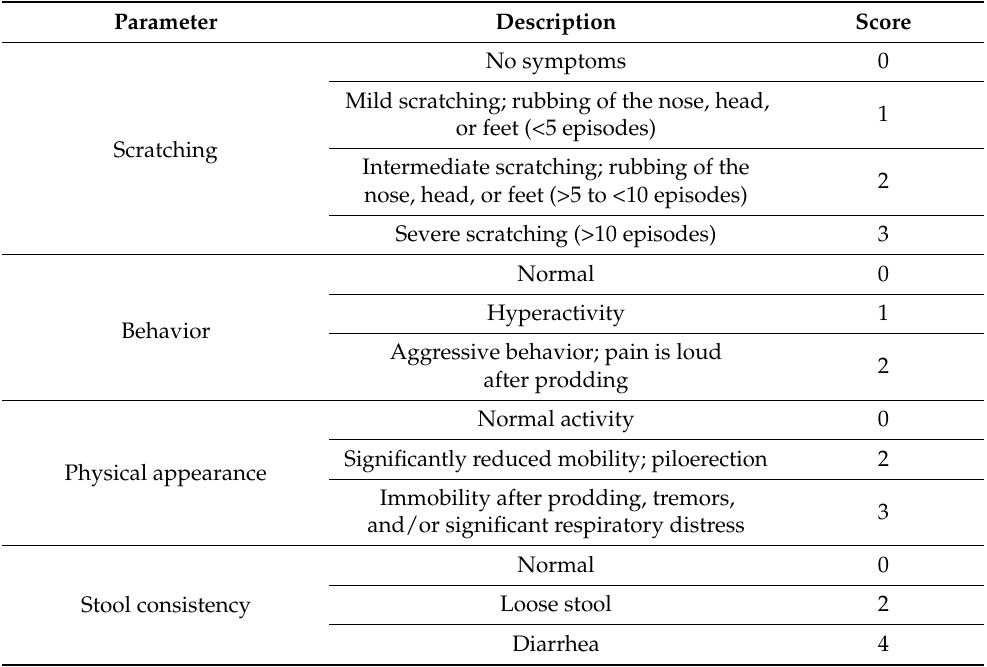
Table 2. Clinical Food Allergy Score